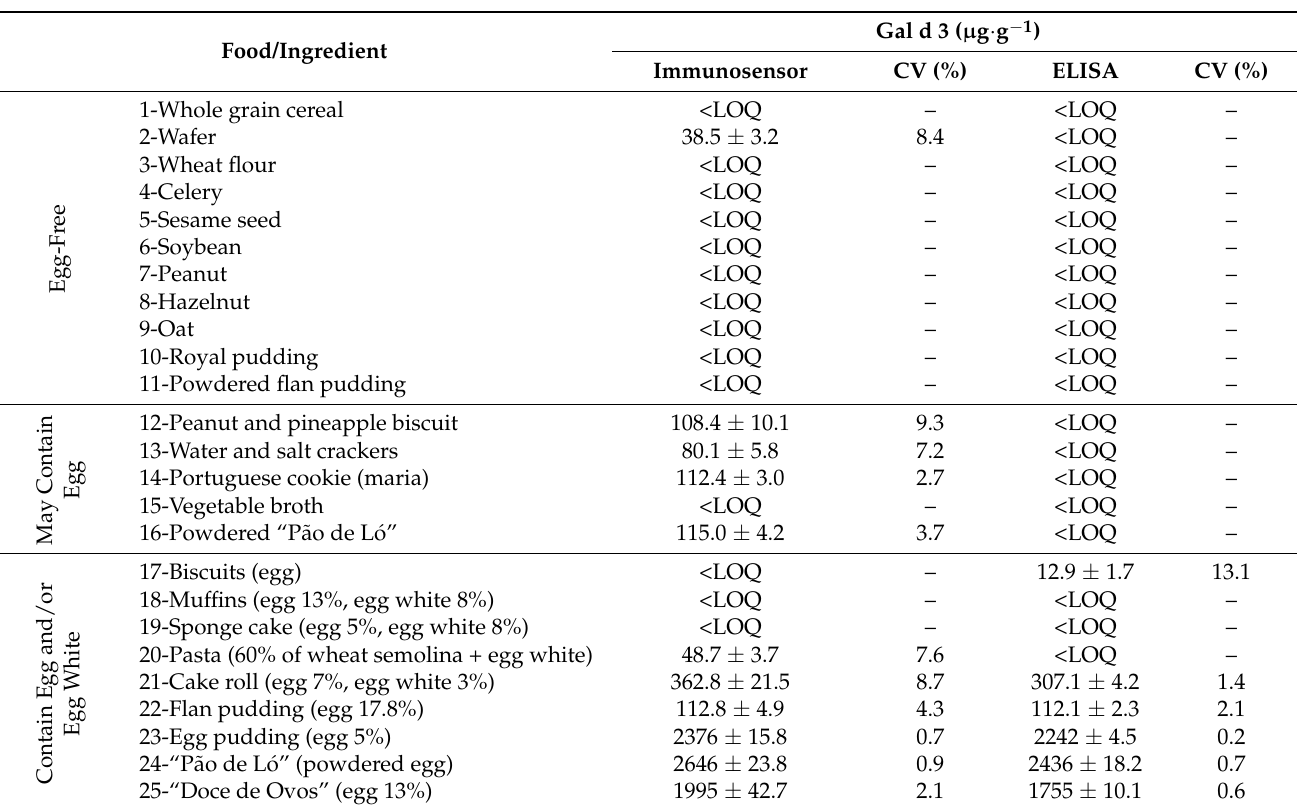
Table 1. Results of the analysis of ovotransferrin ( µ g · g − 1 ) in 25 ingredients and/or food products using the developed amperometric immunosensor and an ELISA